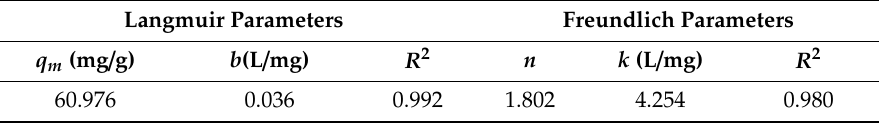
Figure 3. Pb(II) adsorbing isotherm curve at 25 ◦ C ( a ). Langmuir isotherm simulation ( b ). Freundlich isotherm simulation ( c ). Table 2. Langmuir and Freundlich parameters for Pb(II) adsorption at 25 ◦ C. Langmuir Parameters Freundlich